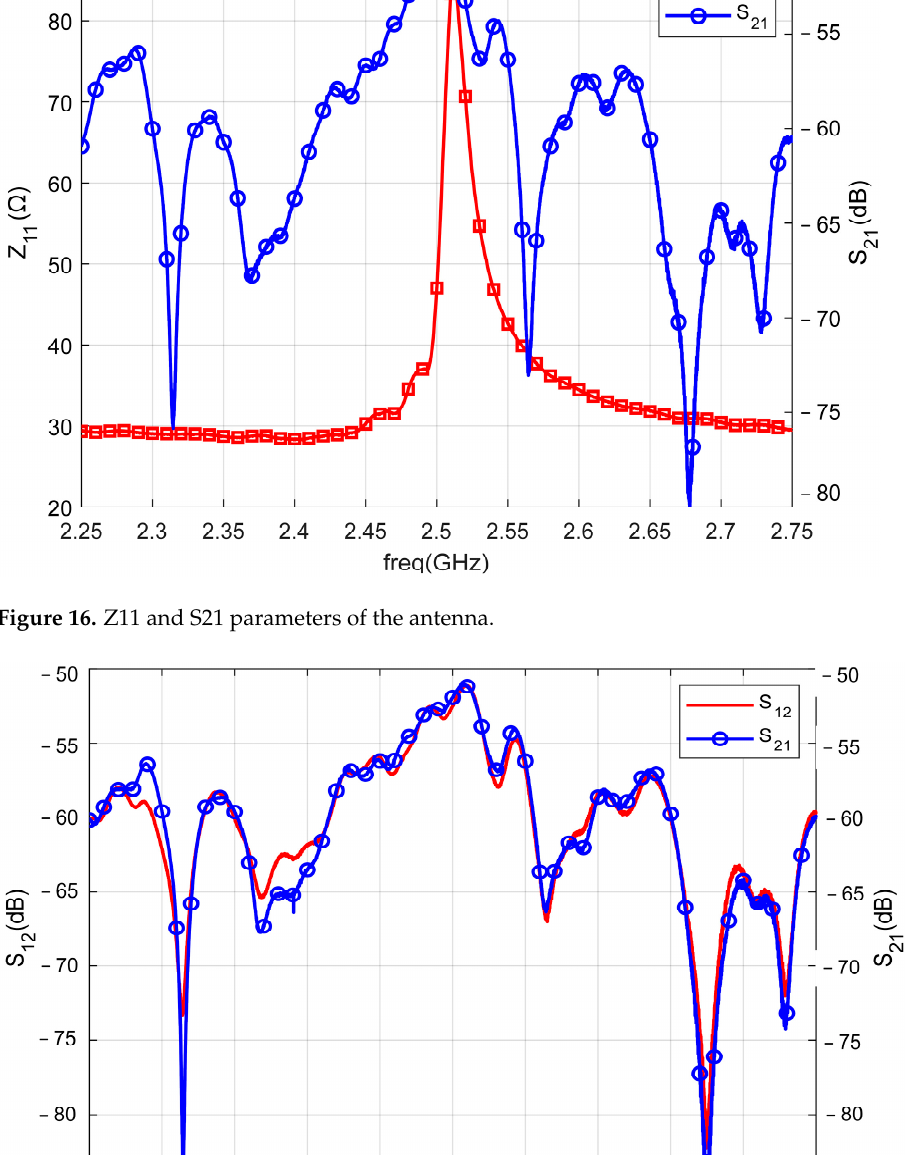
Figure 17. S12 and S21 parameters of the ME antenna.